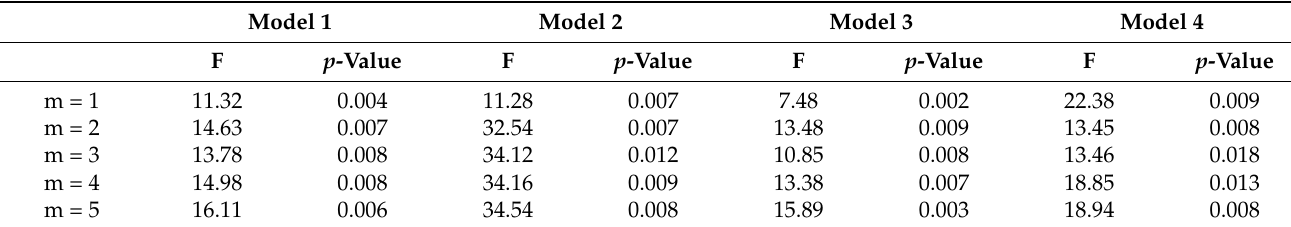
Table 5. The linear test.